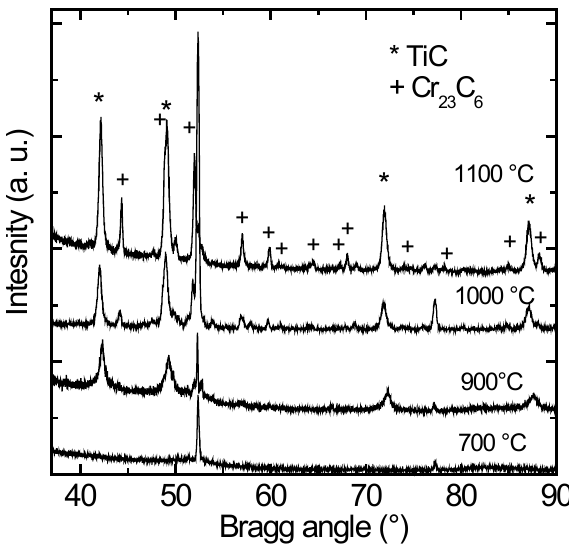
Table 1. Lattice constants and grain size for (Ti